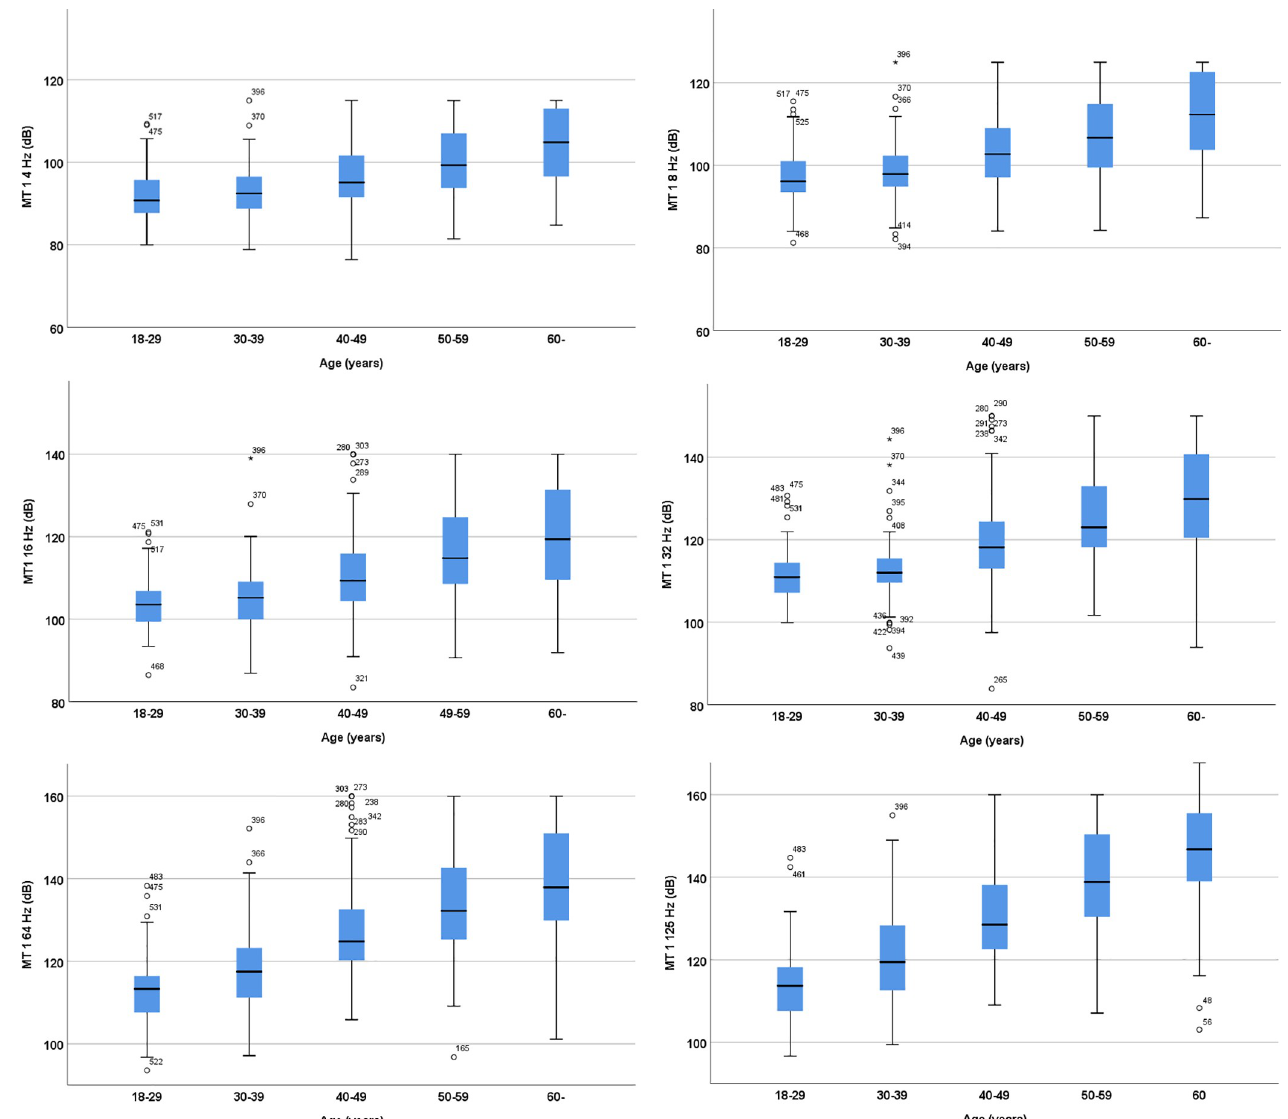
Fig 1. Vibration perception thresholds on the metatarsal head 1 in T1DM patients in different age categories.